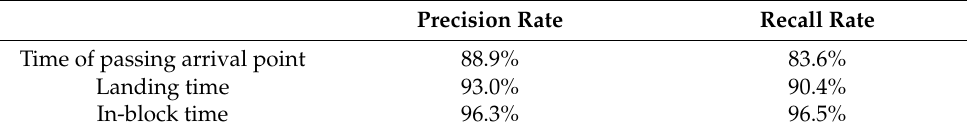
Table 11. Results of precision and recall rates in three phrases.